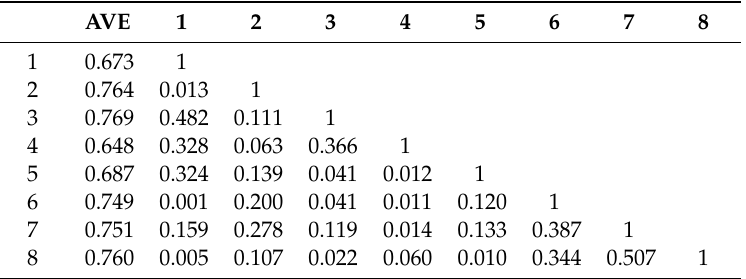
Table 5. Analysis of discriminant validity using average variance